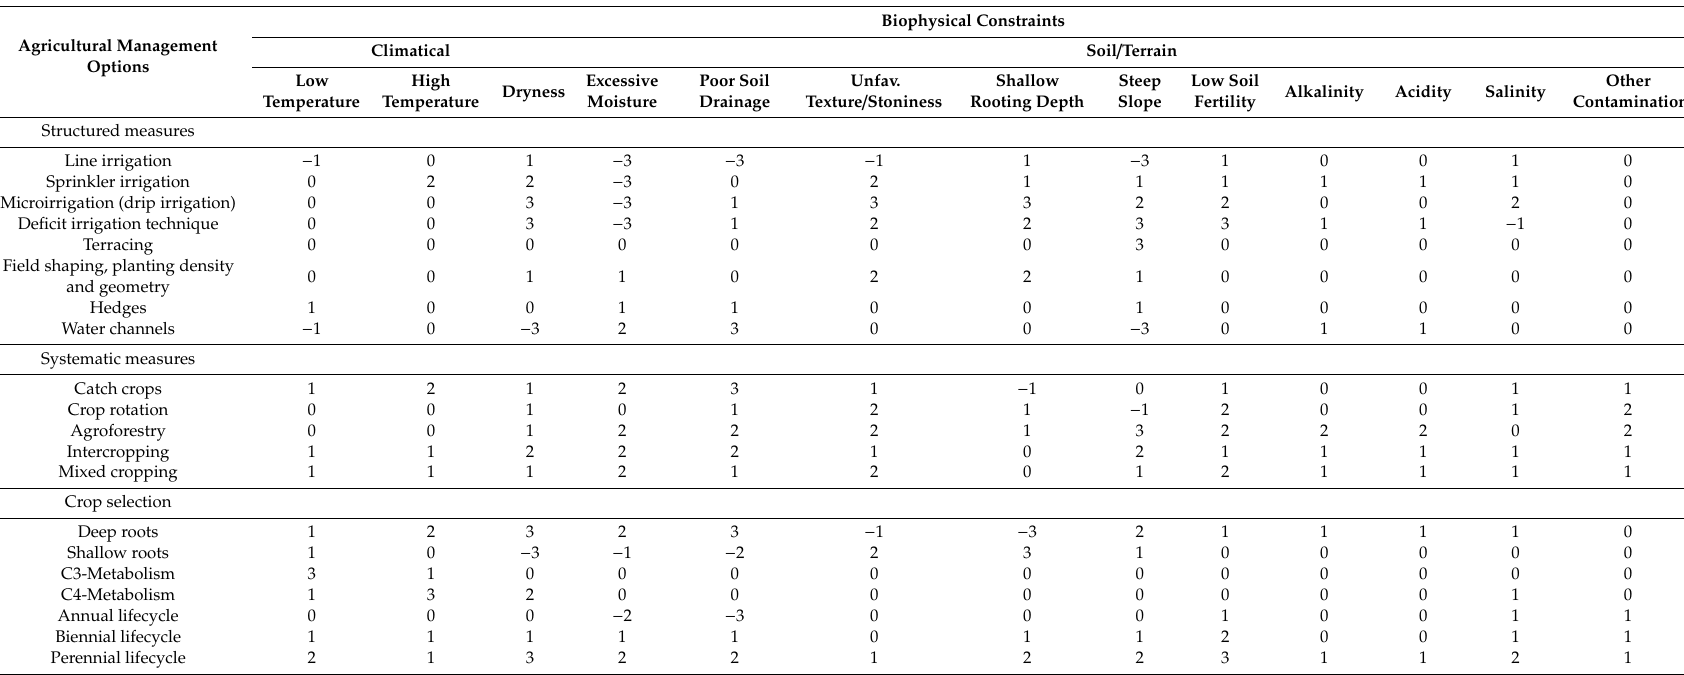
Table A4. Suitability ranking of selected agricultural management options for competing with the prevailing biophysical constraints on arable marginal lands (from − 3 = strong negative e ff ect to + 3 = strong positive e ff